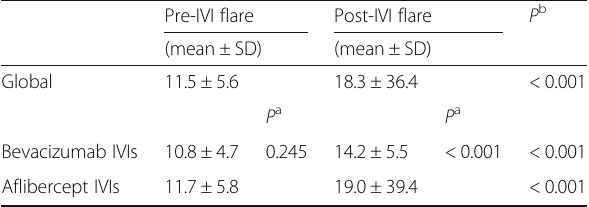
Table 2 Laser flare photometry